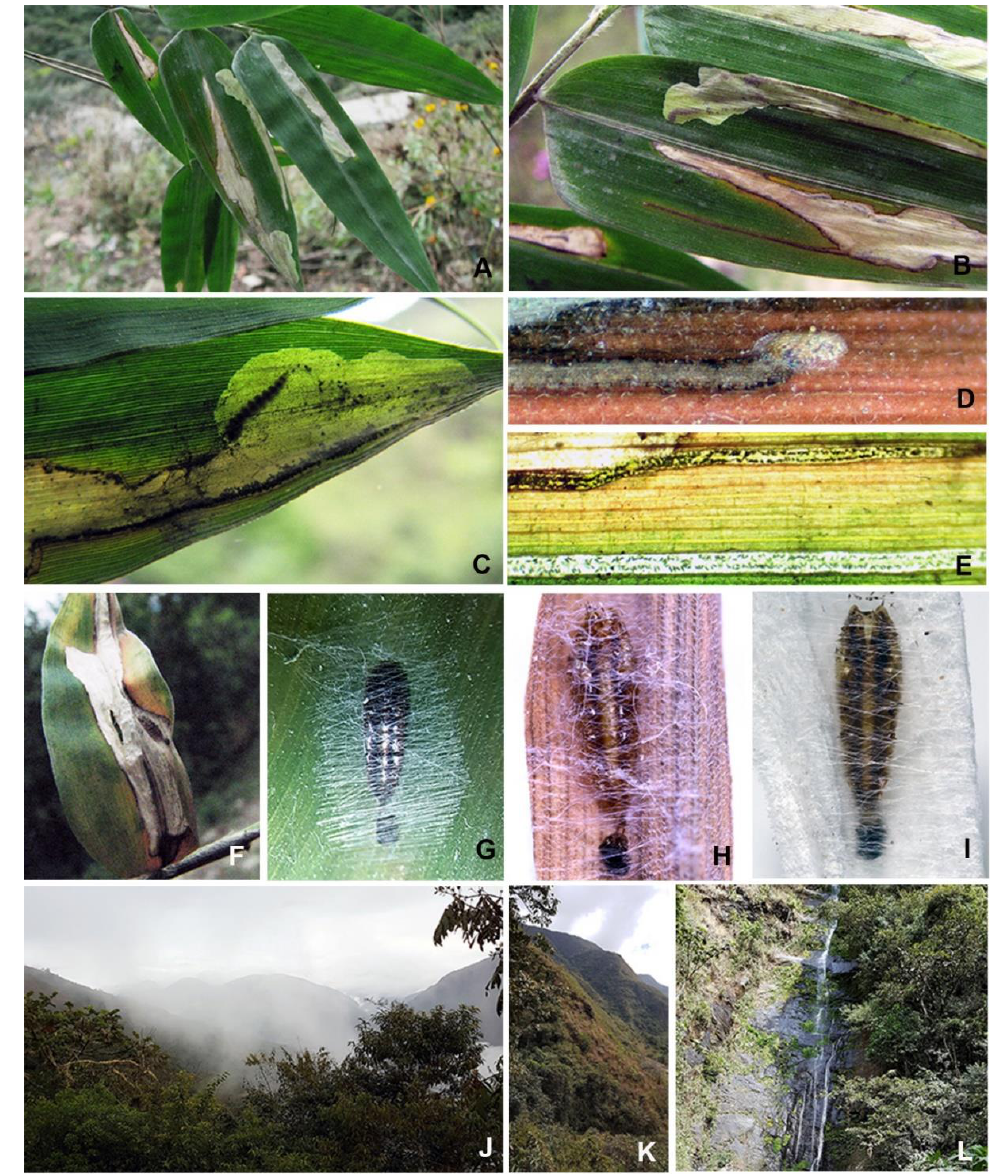
Figure 2. Immature stages and habitat of Elachista albisquamella : ( A – C ) leaf-mines; ( D ) egg; ( E ) frass in the mine; ( F – I ) pupa; and ( J – L ) habitat where the leaf mines were found, Yungas Province, Bo-